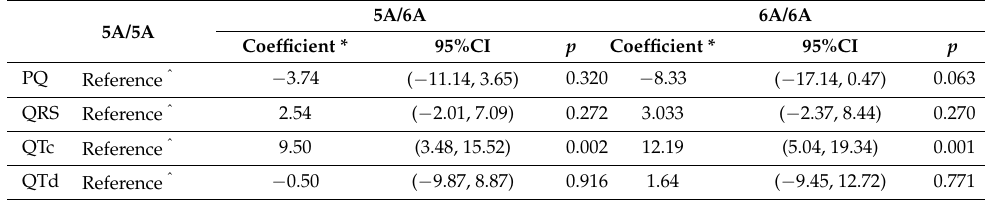
Table 3. Multivariate logistic regression analysis between ECG parameters and MMP-3 polymorphisms.